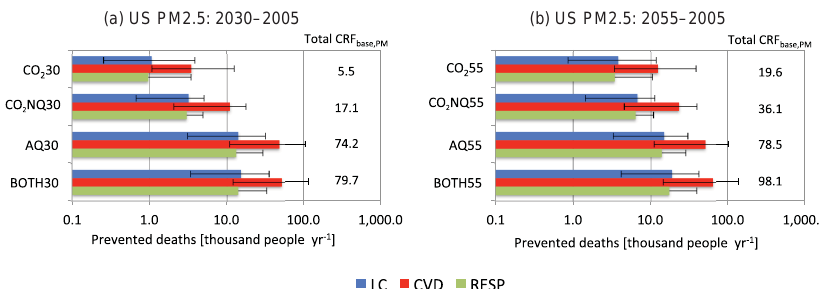
Figure 5. Impact of the air quality regulations and CO 2 reduction policy on US mortality related to PM 2 . 5 . The color bar shows the mortality rate using CRF base , PM . The higher (CRF high , PM ) and lower (CRF low , PM ) bars indicate the spread in mortality change predicted using the range of concentration-response functions used in the study (see Table 2). Note that the x axis is log-scale and has a unit of thousand people per year. The total mortality rate using CRF base , PM is presented on the right side.